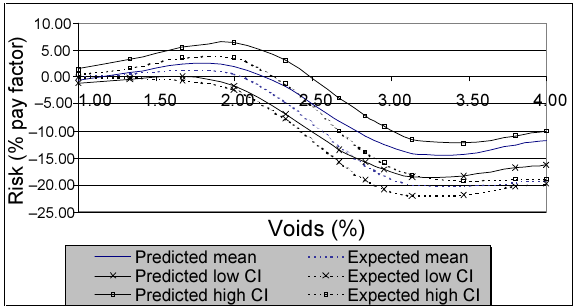
Fig. 7. NN predicted payment risk plot (typical example) Fig. 8 shows another representative case, where the predicted values are significantly away from the expected ones, especially for higher air voids. In this case, however, the predicted values are appreciably away from the expected ones, especially for higher voids values. It should be noted that the most important part of risk plots are the peak risks. This represents one of the extreme cases.